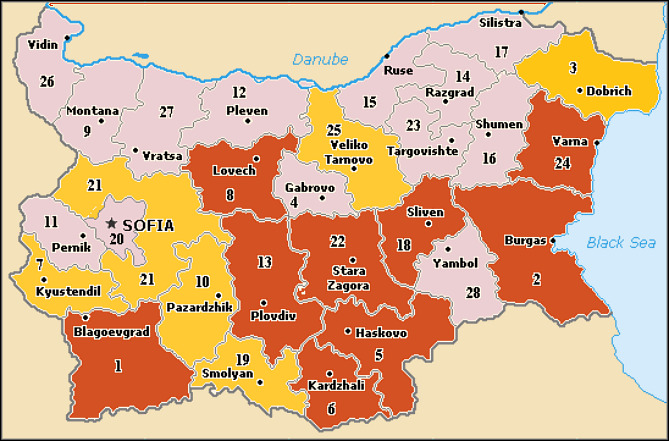
Distribution of cicadas by province in Bulgaria. Pink - 1-4 species per province, orange - 5-8, red - 9-11. Source of the map Pensionero 2011.1 - Blagoevgrad Province, 2 - Burgas Province, 3 - Dobrich Province, 4 - Gabrovo Province, 5 - Haskovo Province, 6 - Kardzhali Province, 7 - Kyustendil Province, 8 - Lovech Province, 9 - Montana Province, 10 - Pazardzhik Province, 11 - Pernik Province, 12 - Pleven Province, 13 - Plovdiv Province, 14 - Razgrad Province, 15 - Ruse Province, 16 - Shumen Province, 17 - Silistra Province, 18 - Sliven Province, 19 - Smolyan Province, 20 - Sofia Province, 21 - Stara Zagora Province, 22 - Targovishte Province, 23 - Varna Province, 24 - Veliko Tarnovo Province, 25 - Vidin Province, 26 - Vratsa Province, 27 - Yambol Province